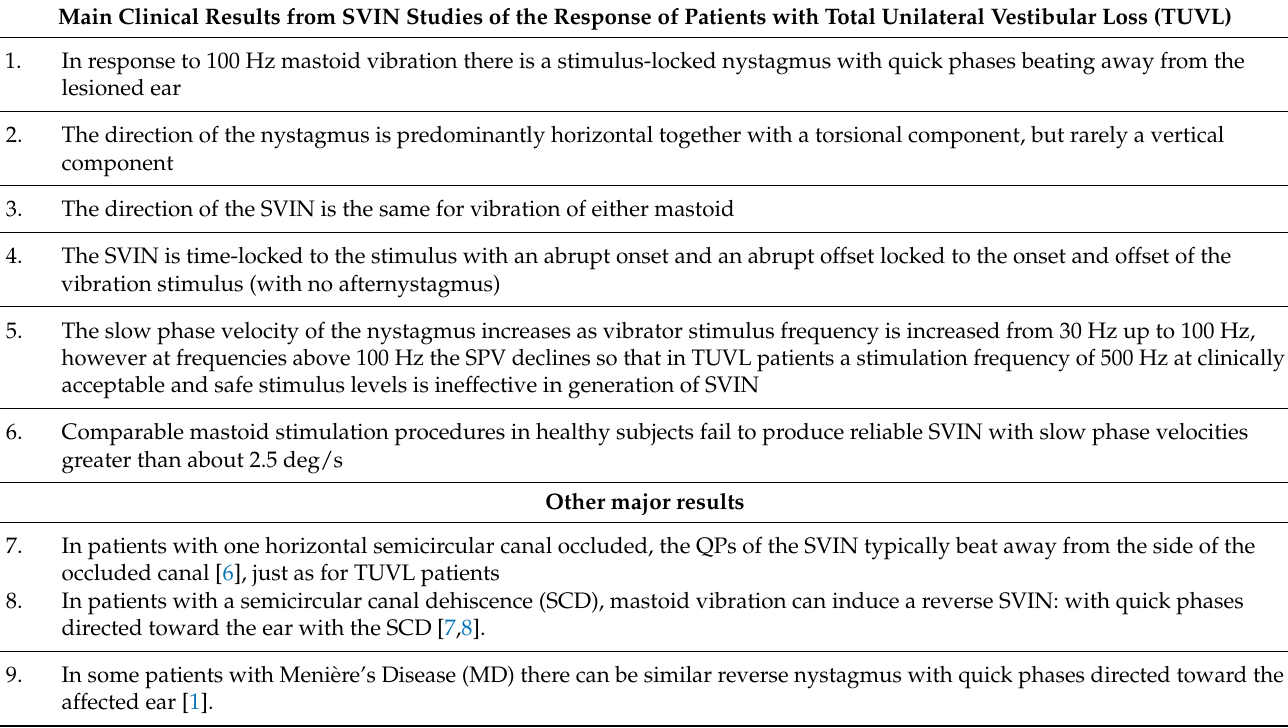
Figure 1. Left panel. Horizontal, vertical, and torsional eye position of a TUVL patient during skull vibration. The onset and offset of the skull vibration are shown by asterisks. The horizontal and torsional components start at stimulus onset and cease at offset. The records show the horizontal, vertical and torsional eye movement recordings (Synapsys) of a TUVL patient with a total left-sided vestibular loss in response to stimulation of the right mastoid (RM). The vibration stimulus causes horizontal and torsional quick phases to the right, away from the affected left ear. In the Synapsys recording conventions, a horizontal quick phase to the right is shown by an upwards deflection of the trace and a torsional quick phase to the right (with the upper pole of the eye rolling to the patient’s right side) is shown by a downward deflection of the trace. The horizontal (and torsional) quick phases are directed away from the lesioned ear. There is no consistent vertical component. Right panel. The slow phase eye velocities corresponding to the eye position records. From [1] with permission. Table 1. A summary of the main characteristics of the SVIN response of patients with total unilateral vestibular loss (TUVL) summarized from [1] and related papers by the Dumas group.